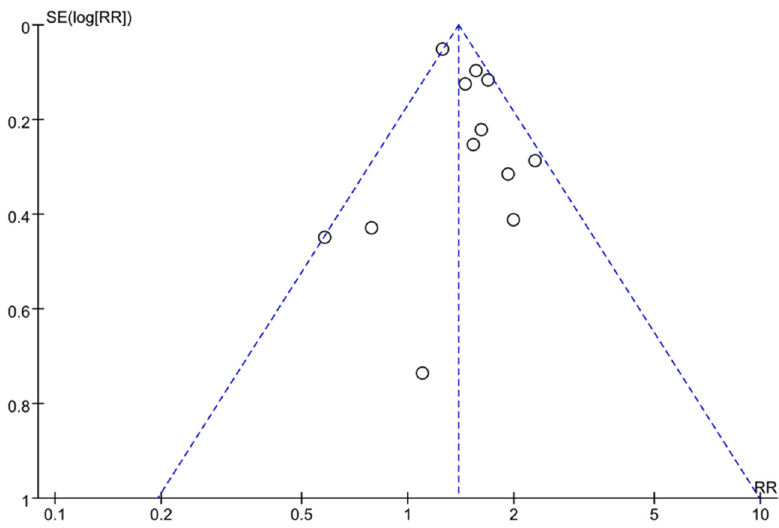
Figure 4. Funnel plots of all studies showing that publication bias existed.